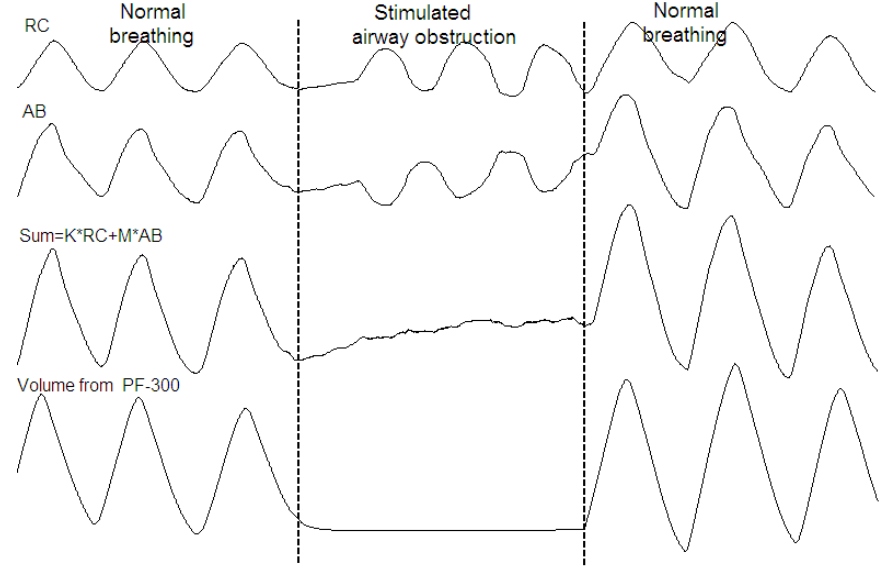
Figure 7. The weighted sum of RC and AB band signals during normal breathing and simulated airway